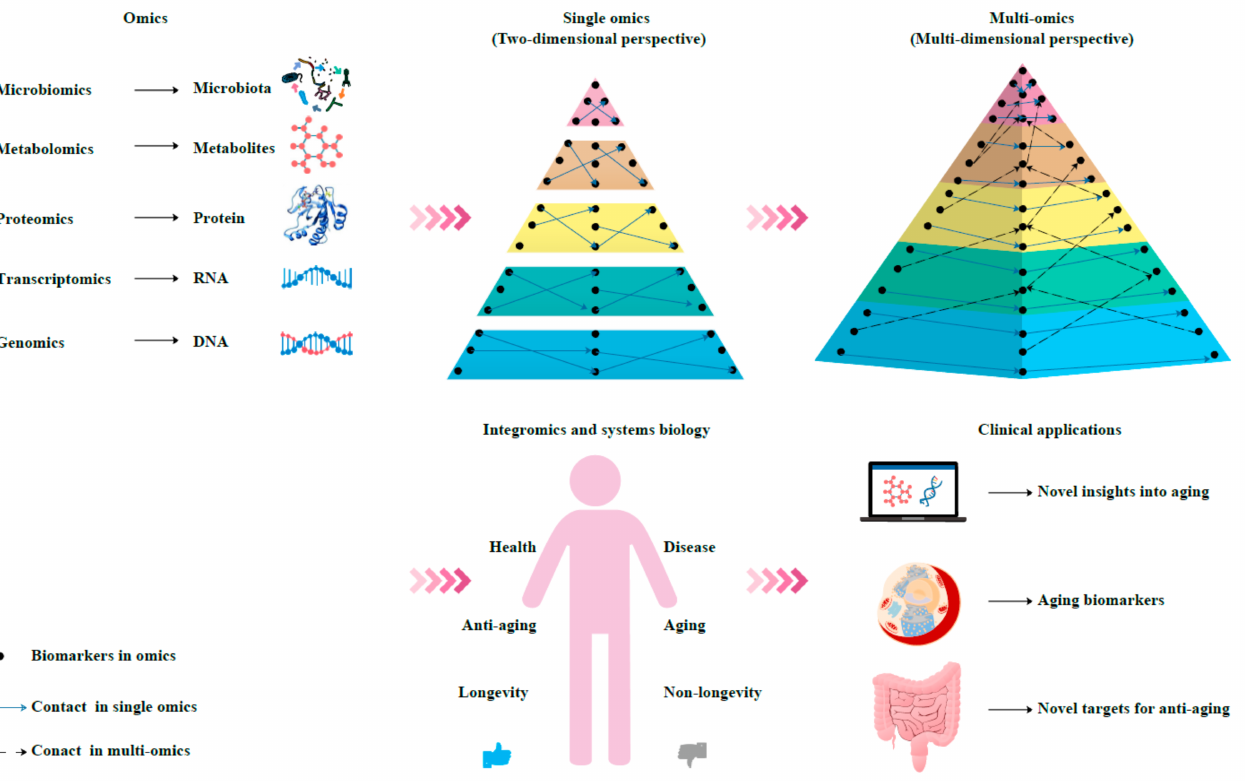
Figure 2. Schematic diagram of an integrated multi-omics approach to the research and application of aging biomarkers. Genomics, transcriptomics, proteomics, metabolomics, and microbiomics enable the high-throughput quantitative profiling of molecules in biological systems to reveal aging-related changes. Combining single-omics data with integromics and systems biology contributes to an increased understanding of the mechanisms of aging and paves the way for the development and utilization of aging biomarkers and novel antiaging